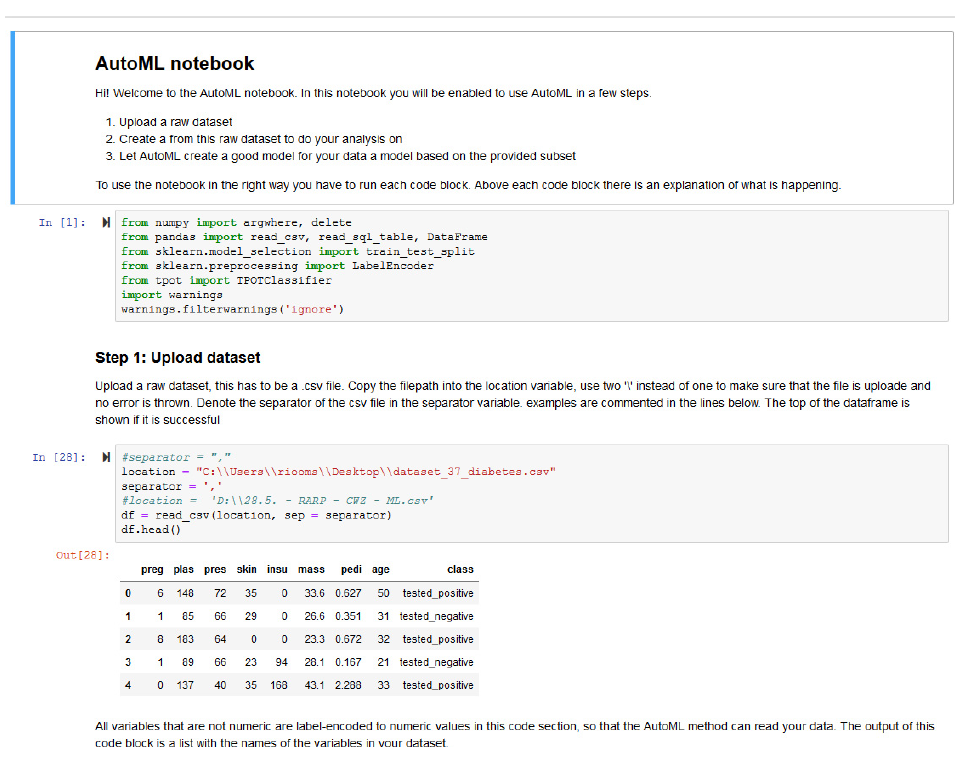
Figure A3. Screenshot of AutoML artefact B, the Jupyter notebook interface (preference: Code).